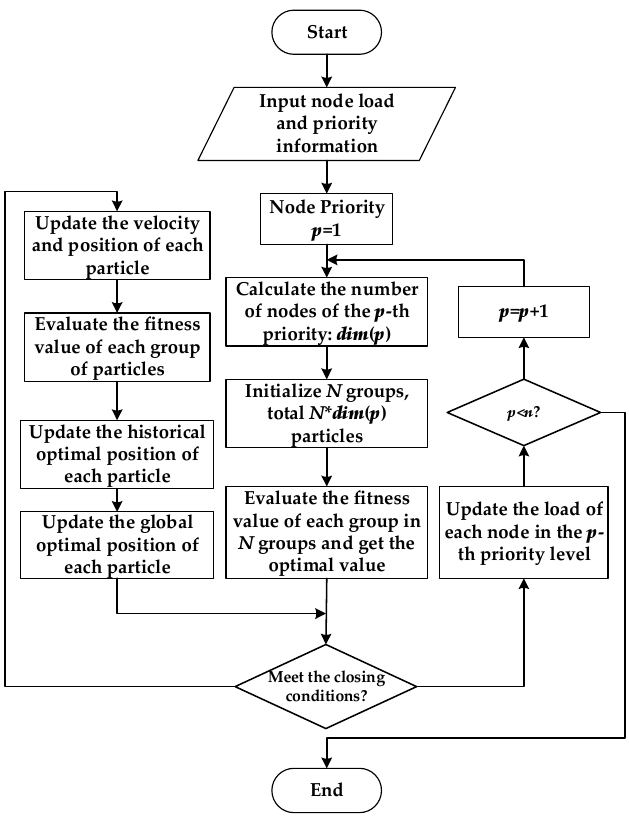
Figure 5. Particle swarm algorithm-solving process.